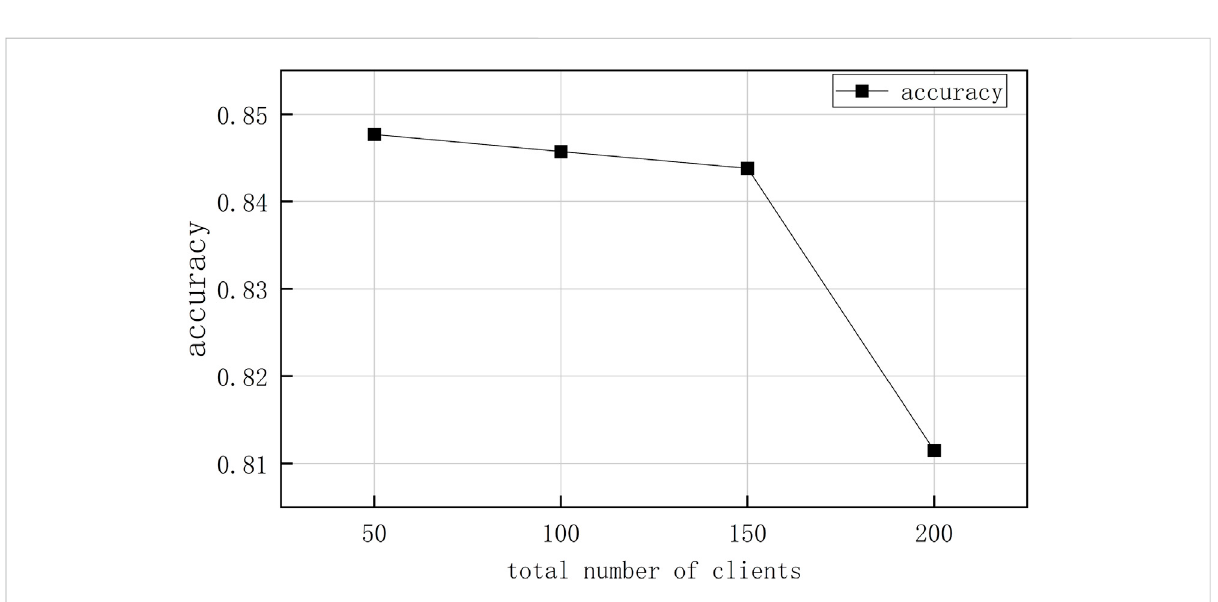
FIGURE 3 The effect of the total number of clients on the